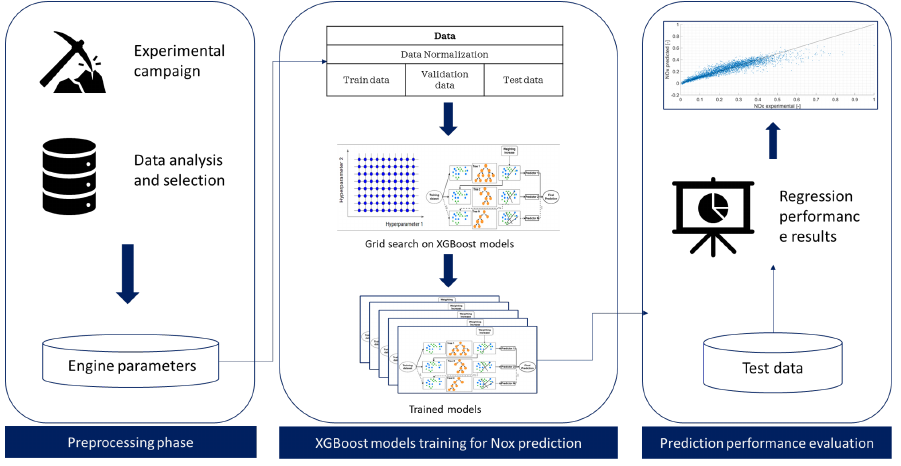
Figure 1. The proposed method for the model’s performance